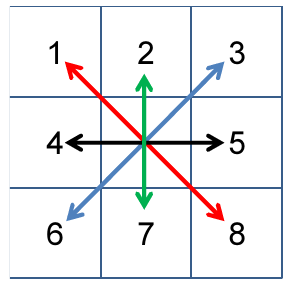
Figure 3. Pairings for calculating gradient angle